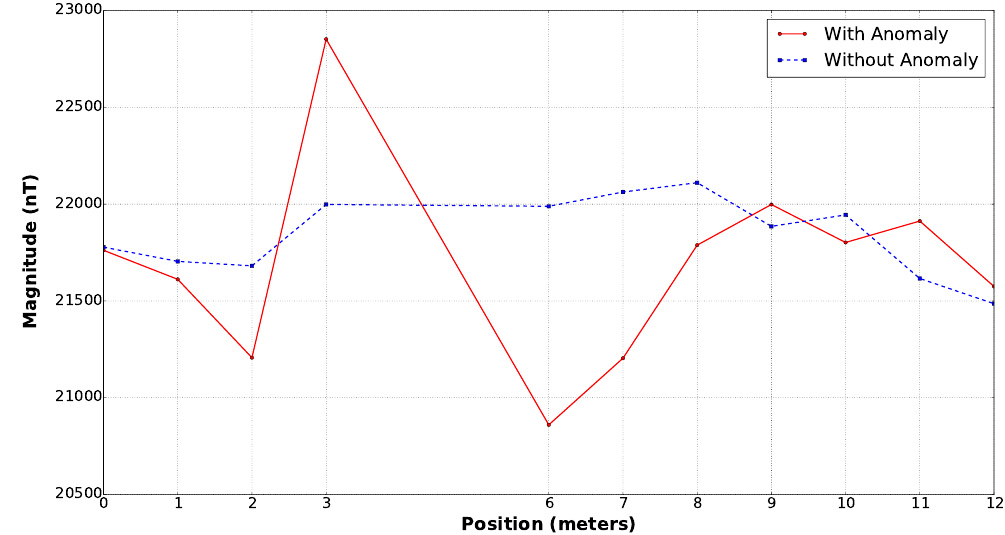
Figure 12. Survey along a test profile aligned to the magnetic north. Two survey has been carried, with and without a ferromagnetic test body containing approximately 300 kg of low